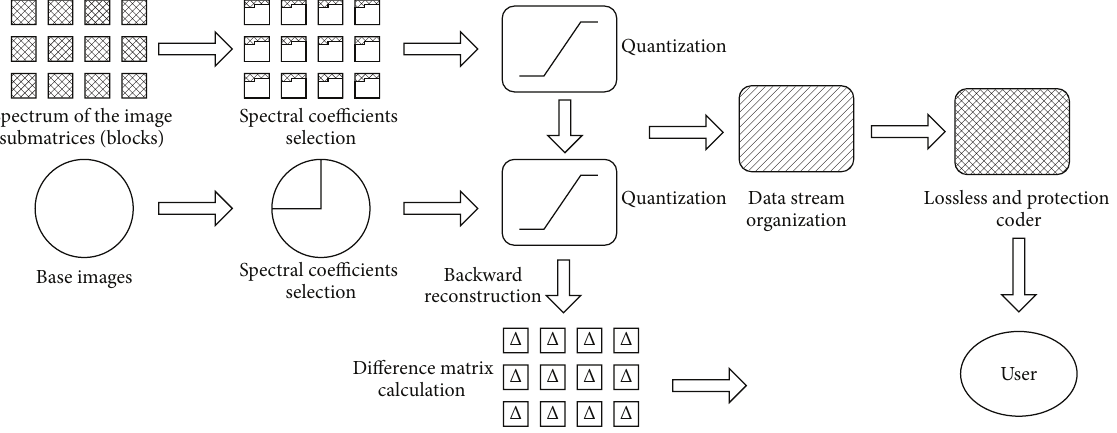
Figure 6: The KLT coder for astronomical image